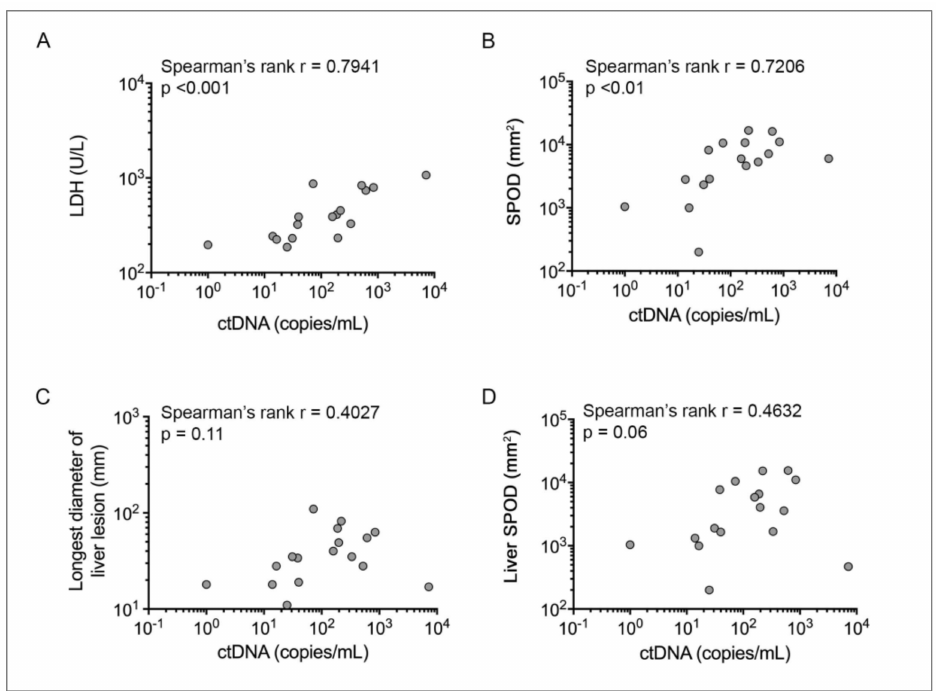
Figure 1. Relationship between uveal melanoma ctDNA (copies/mL), tumor burden and LDH. Spearman’s rank correlation between ctDNA copies/mL and ( A ) LDH (U/L), p < 0.001, ( B ) SPOD (mm 2 ), p < 0.01, ( C ) Longest liver lesion (mm), p = 0.11, ( D ) Liver SPOD (mm2), p = 0.06. Graph shows ctDNA+1